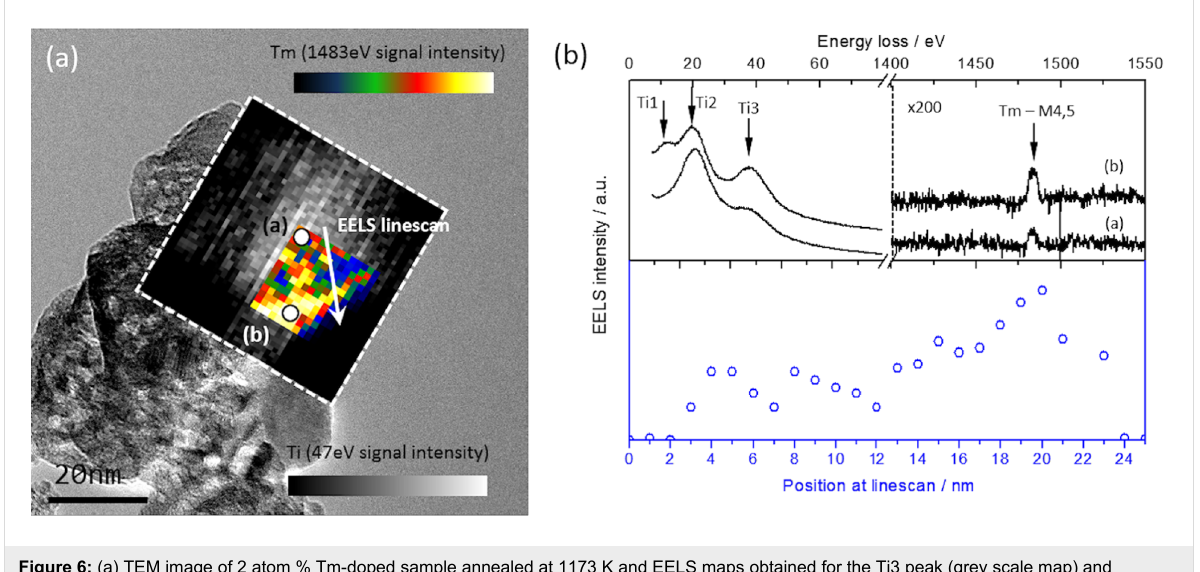
Figure 6: (a) TEM image of 2 atom % Tm-doped sample annealed at 1173 K and EELS maps obtained for the Ti3 peak (grey scale map) and Tm-M 4,5 signal (temperature map). (b) EELS spectra obtained at positions (a) and (b) in Figure 6a, corresponding to the core and edge of the nanoparticle. Also given is the Tm-M 4,5 signal intensity profile along the corresponding linescan shown in Figure